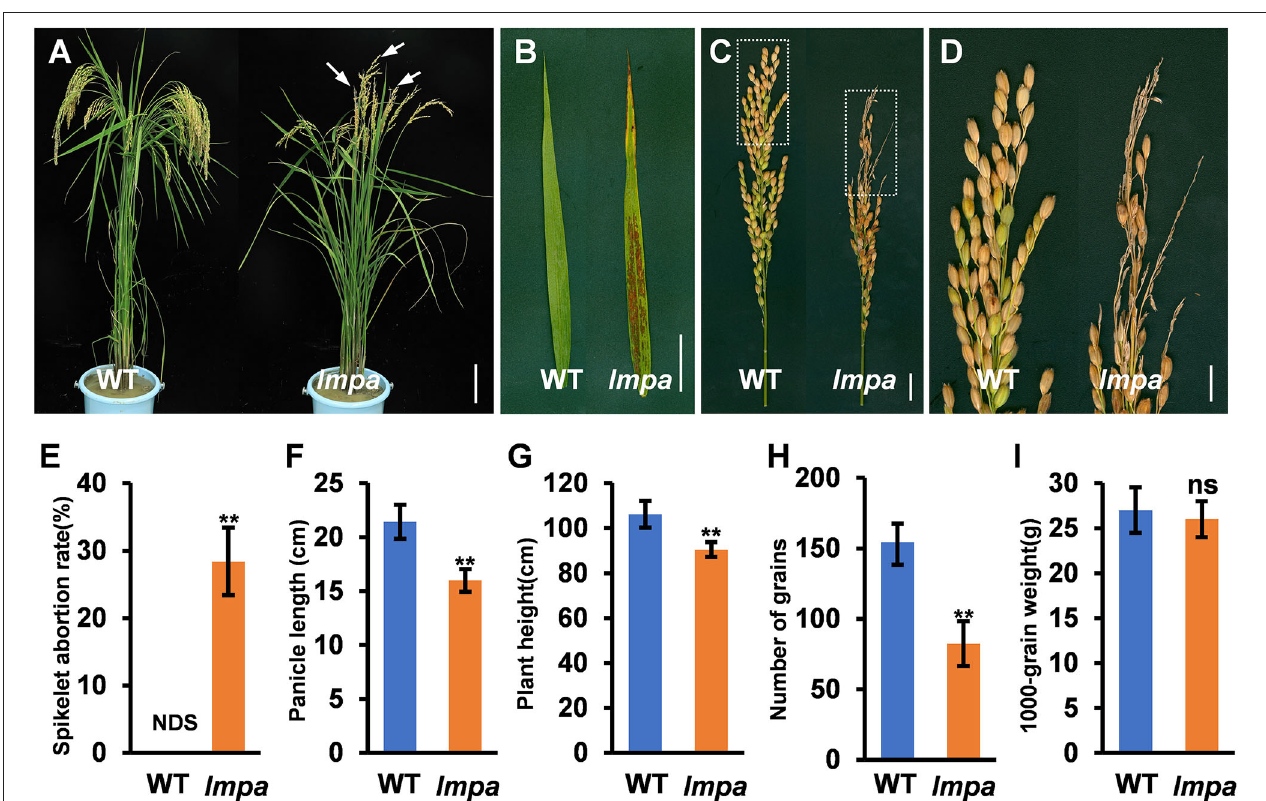
FIGURE 1 | Phenotypic characterization of the lmpa mutant. (A) Phenotypes of the mature wild-type (WT) plant and lmpa mutant. The arrow indicates the degenerated spikelets. (B) Flag leaf phenotype in WT and lmpa mutant. (C) Phenotypic comparison of mature panicles between WT and lmpa mutant. (D) Magnified view of the white boxed areas in (C) . (E–I) Comparison of spikelet abortion rate (E) , panicle length (F) , plant height (G) , number of grains per panicle (H) , and 1,000-grain weight (I) between the WT and lmpa mutant. Error bars represent standard deviation (SD) ( n = 10); **Significant difference at p < 0.01 compared with the WT by Student’s t- test. NDS, no degenerated spikelet. Bars = 10cm in (A) , 5cm in (B) , 2cm in (C) , and 1cm in (D)